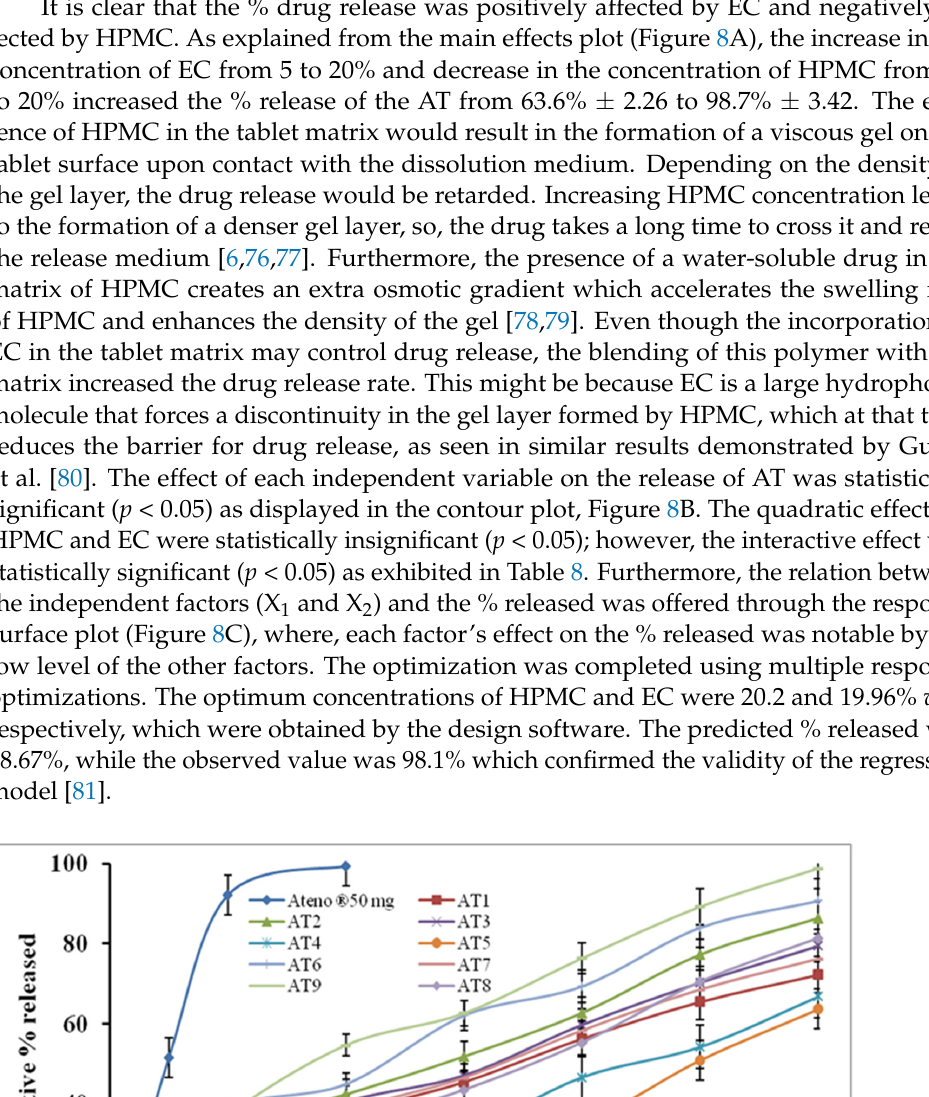
Figure 8. ( A – C ) The response surface plot ( A ), contour plots ( B ), and main effects plots ( C ) estimate the effect of independent variables on % released after 12 h. Table 8. Analysis of variance for the % released after 12 h. Source